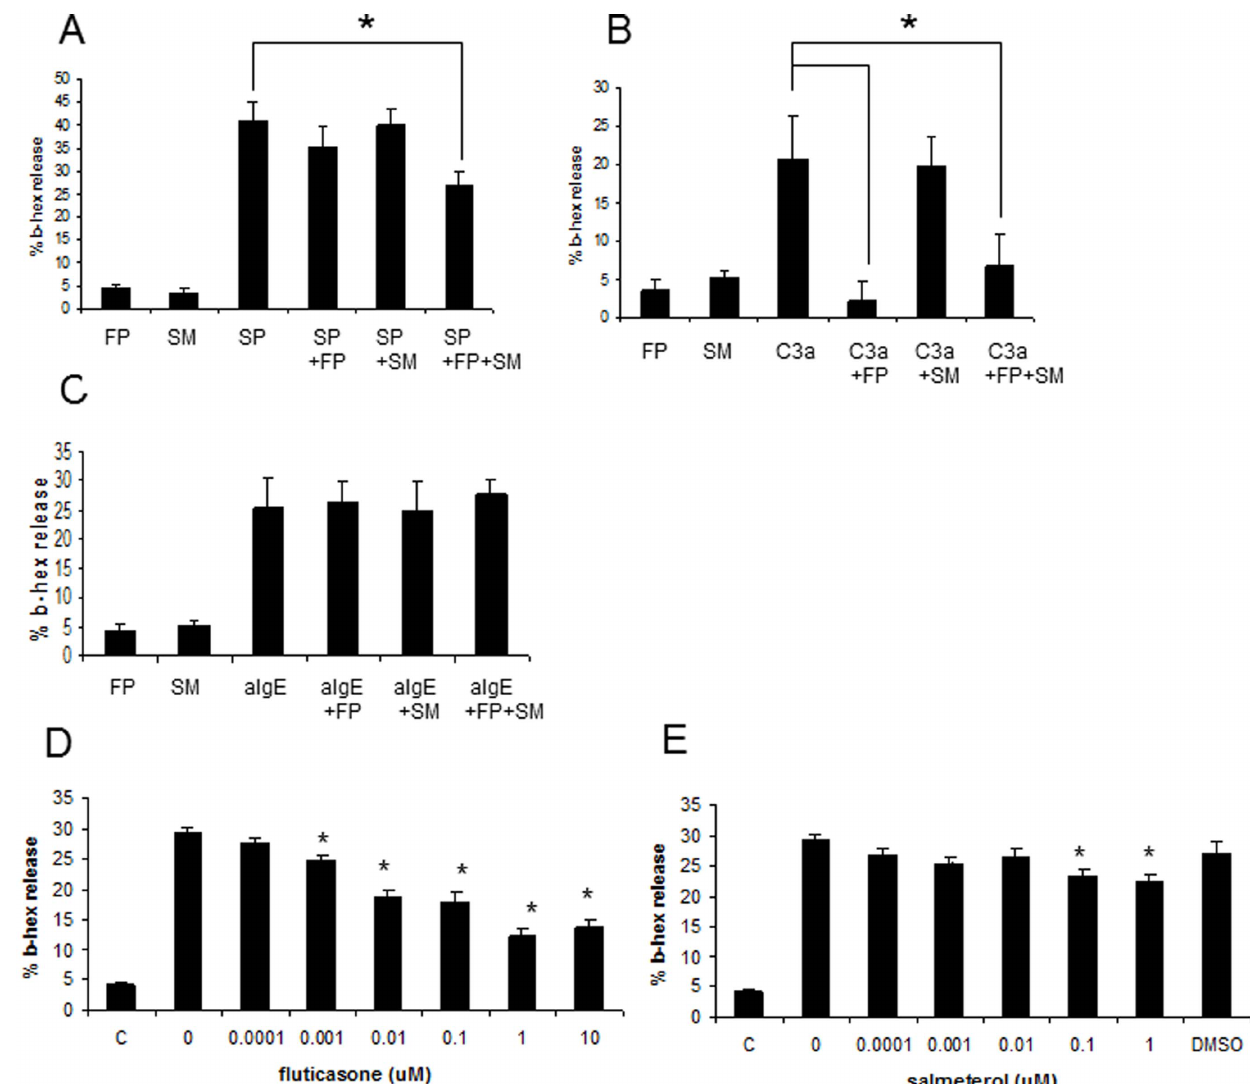
Figure 1. Fluticasone and salmeterol inhibit human mast cell degranulation. A , LAD2 human mast cells were treated with fluticasone (0.1 nM) or salmeterol (10 nM) or both for 20 hr, then stimulated with SP (1 ug/mL) for 30 min and b -hexosaminidase release was measured (n=5, *=p , 0.01). B , LAD2 human mast cells were treated with fluticasone (0.1 uM) or salmeterol (1 uM) or both for 20 hr, then stimulated with C3a (100 ng/mL) for 30 min and b -hexosaminidase release was measured (n=5, *=p-value , 0.01) C , LAD2 human mast cells were sensitized with human myeloma IgE (0.5 ug/mL) for 16 hr, then treated with fluticasone (0.1 uM) or salmeterol (1 uM) or both for 20 hr and stimulated with anti-IgE (100 ug/mL) for 30 min and b -hexosaminidase release was measured (n=5, *=p-value , 0.01). D , LAD2 human mast cells were treated with fluticasone for 20 hr, then stimulated with SP (1 ug/mL) for 30 min and b -hexosaminidase release was measured (n=5, *=p , 0.05 when compared to untreated control (C)). E , LAD2 human mast cells were treated with salmeterol for 20 hr and stimulated with SP (100 ng/mL) for 30 min and b - hexosaminidase release was measured (n=5, *=p-value , 0.05 when compared to untreated control (C)).